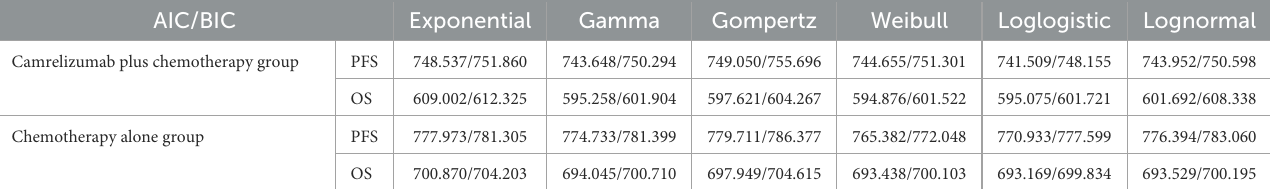
TABLE 1 AIC and BIC values of distributions.